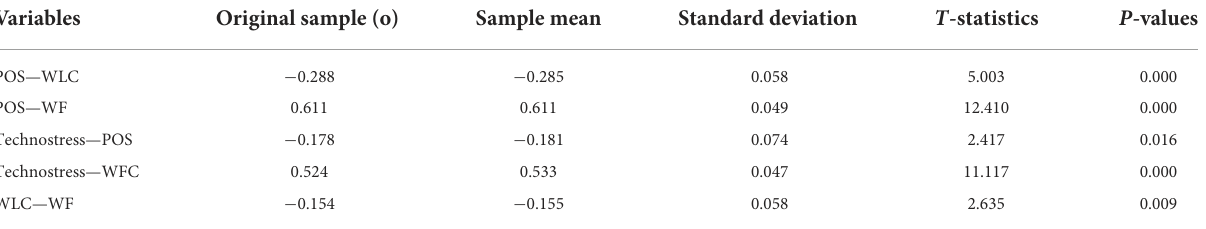
TABLE 5 Path coefficients: the inner model.